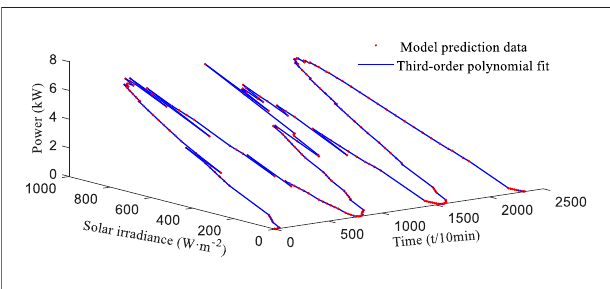
FIGURE 6 | Observation equation